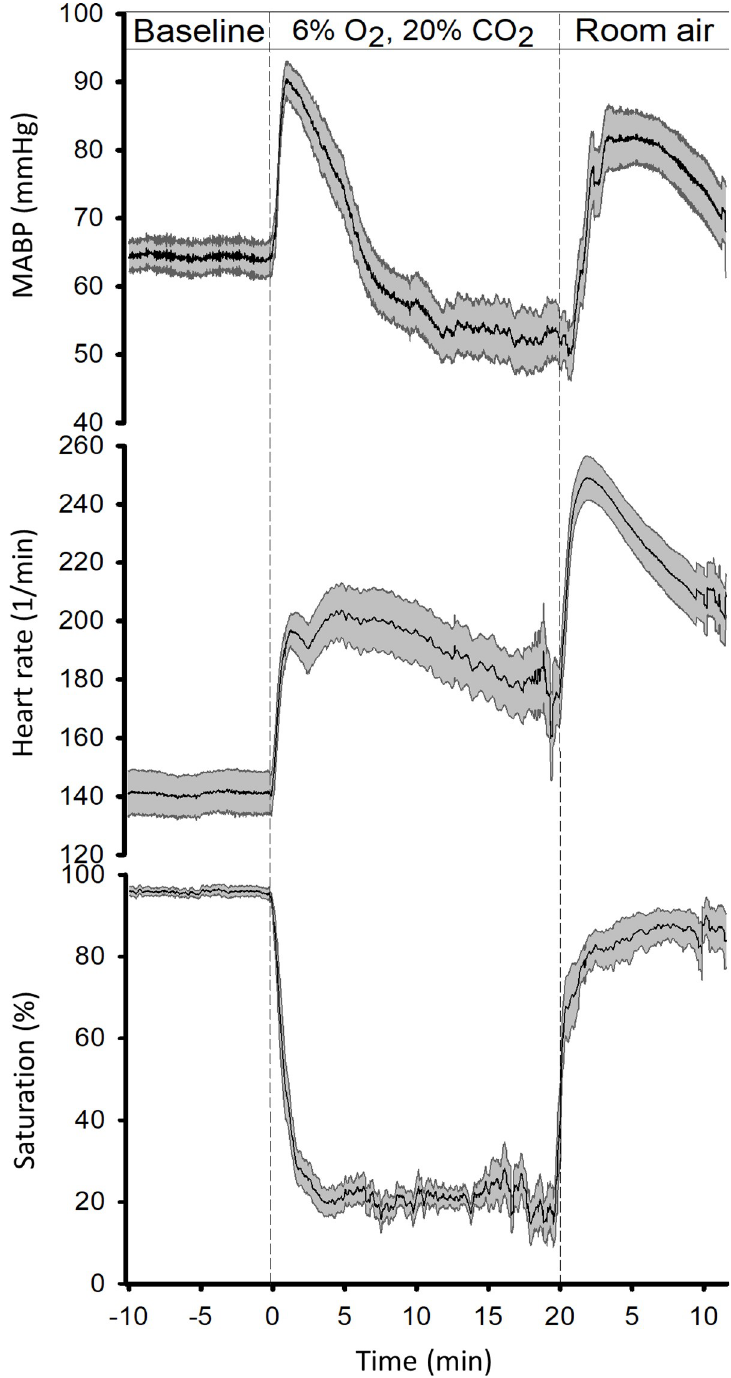
Fig 2. Hemodynamic and oxygenation changes during PA. In all panels, solid lines indicate the mean and the grey shaded area the SEM. (n = 13). After obtaining baselines, PA was initiated resulting first in the transient elevation of mean arterial blood pressure (MABP, top panel) and heart rate (HR, middle panel) accompanying the rapid fall in blood oxygen saturation (pulsoxymetry, bottom panel). While blood oxygen saturation remained ~20% throughout the asphyxia, after the initial peak, MABP fell continuously below baseline, whereas the drop in HR was more moderate and HR remained elevated. Reventilation with air quickly restored oxygen saturation and induced a second transient elevation in both MABP and